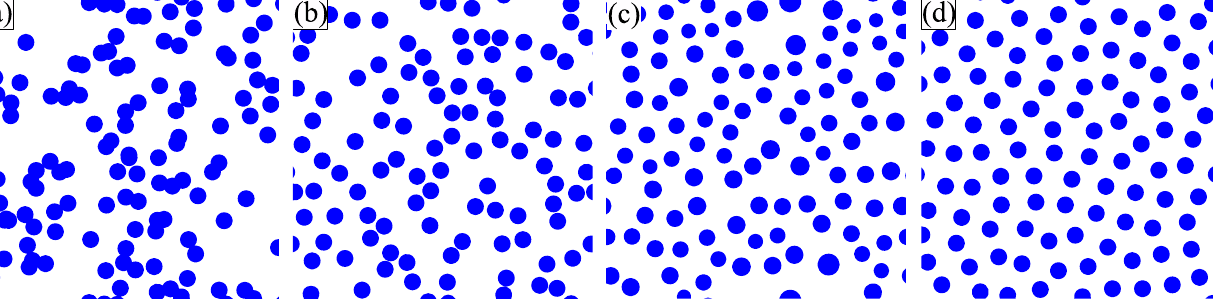
FIG. 4. Representative images of configurations of the four models of 2D disordered particulate media described in this section. These include (a) overlapping spheres, (b) equilibrium packings, (c) class I hyperuniform polydisperse packings, and (d) stealthy hyperuniform packings. For all models, the volume fraction of the dispersed phase (shown in black) is ϕ 2 ¼ 0 . 25 . Note that (a) and (b) are not hyperuniform. While these models consist of distributions of particles, both overlapping and nonoverlapping, the formulas derived in Sec. IV can be applied to any two-phase microstructure. Indeed, Appendix D describes applications to media with phase-inversion